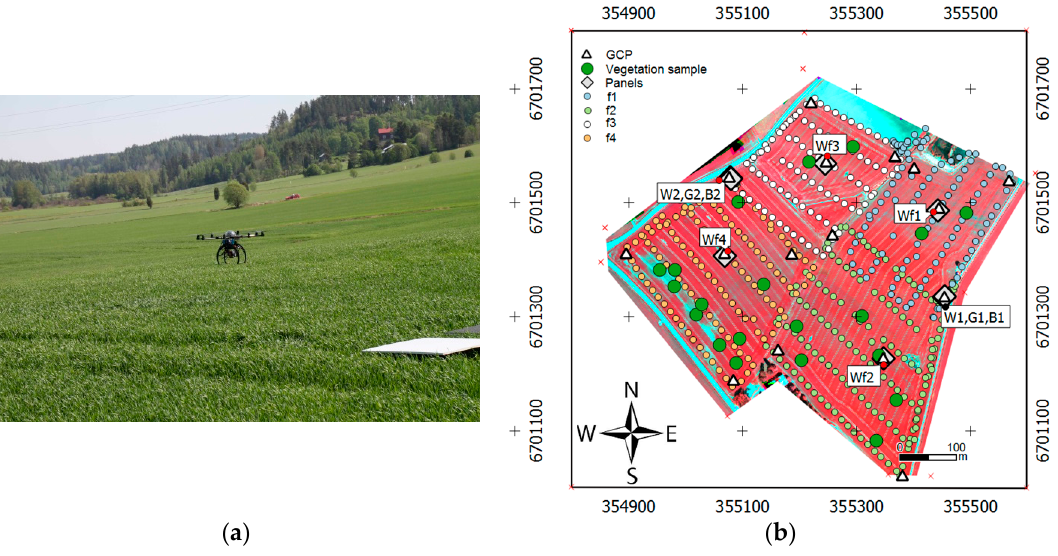
Figure 2. ( a ) An unmanned airborne vehicle (UAV) flight on 23 May 2014 (Photo by Lauri Markelin); ( b ) map of the test area showing flights f1, f2, f3, f4, ground control points (GCP), vegetation samples and reflectance panels.